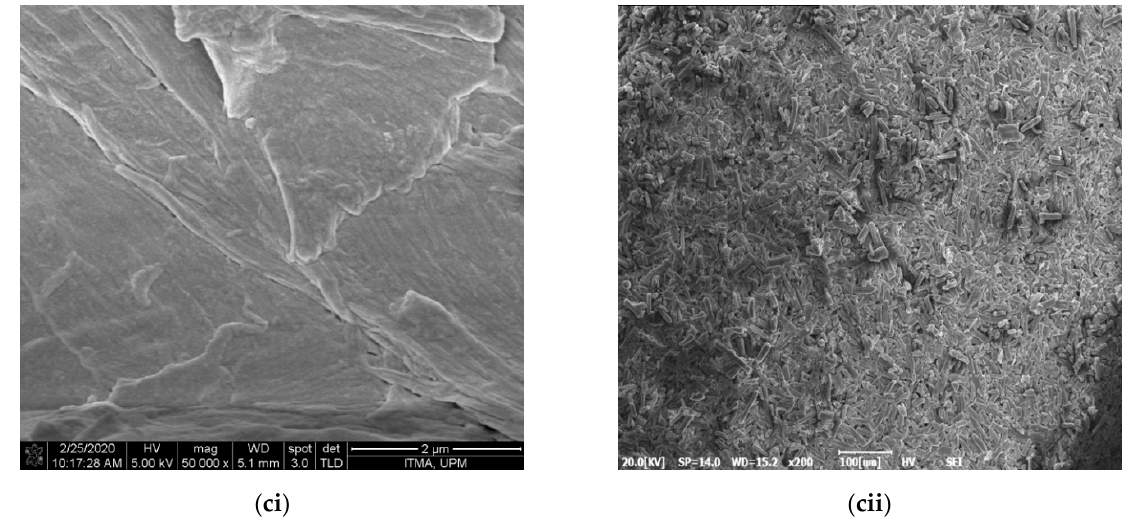
Figure 1. FESEM images of ( a ) CPNC1, ( b ) CPNC2, and ( c ) CPNC3 under ×1000 ( i ) and ×50,000 ( ii ) viewing.